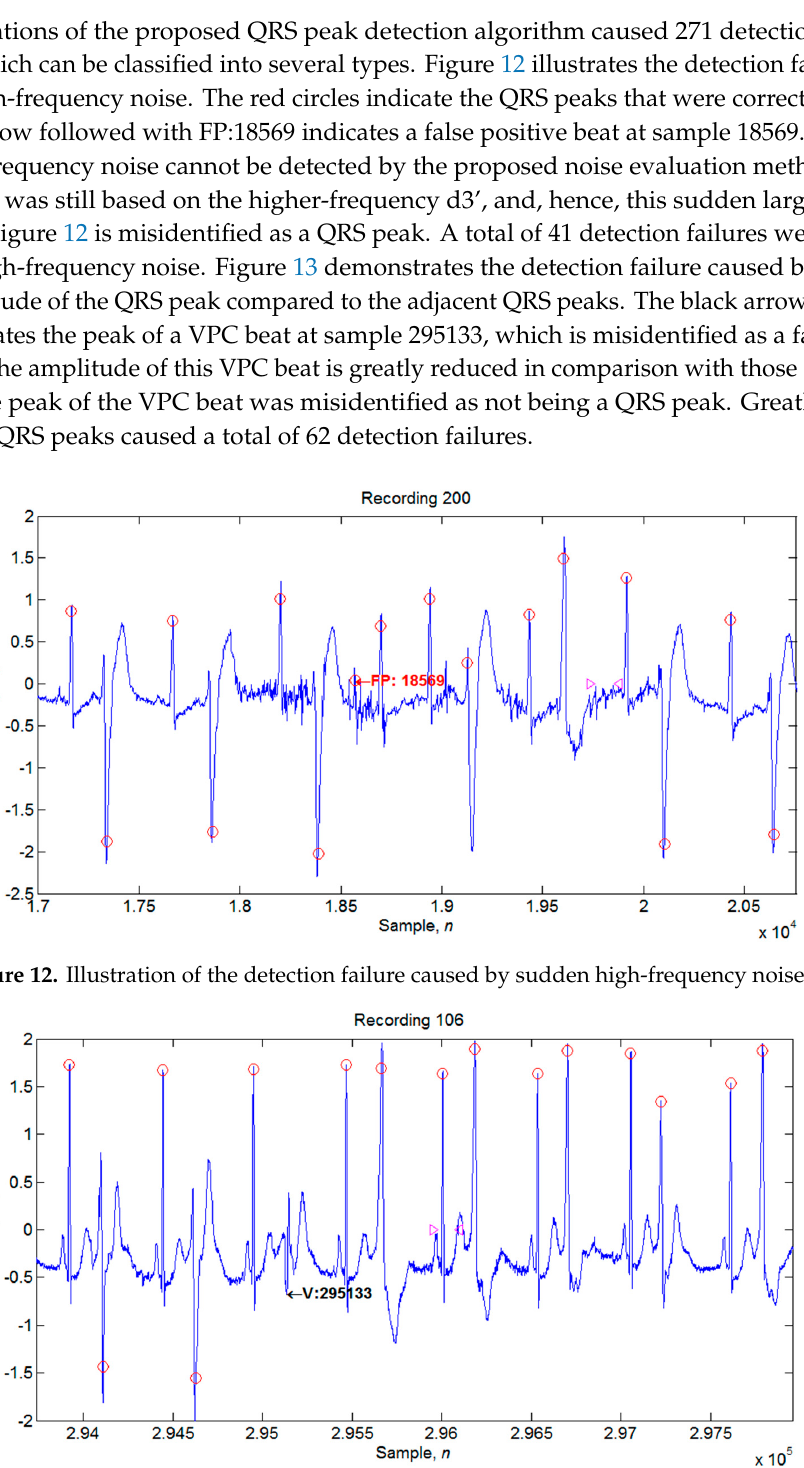
Figure 14. Illustration of the detection failures caused by large-amplitude artifacts.